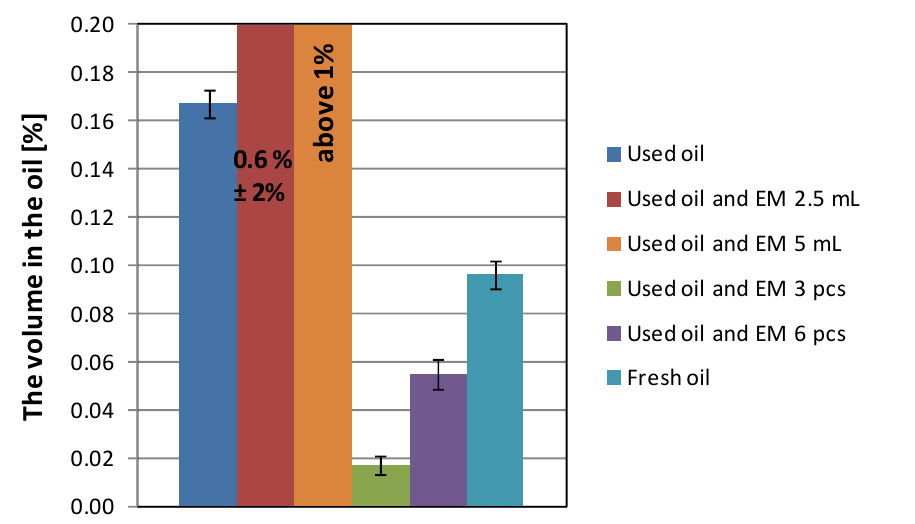
Figure 9. Water content in used oil and used oil with effective organisms in liquid form and ceramic tubes.